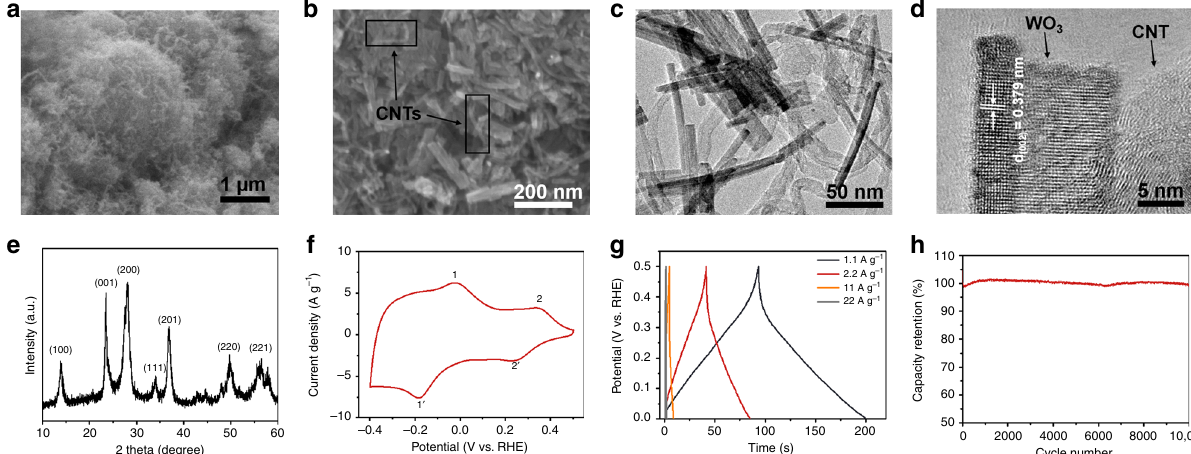
Fig. 2 Structure and electrochemical characterizations of the composite. a , b SEM, c TEM, and d high-resolution TEM images of the composite. e XRD pattern of the composite showing a hexagonal WO 3 crystalline structure. f A cyclic voltammetry curve of the composite from − 0.4 to 0.5 V vs. reversible hydrogen electrode (RHE). g Galvanostatic charge/discharge curves of the composite at different current densities. h Cycling stability of the composite electrode in 0.5 M H 2 SO 4 Fig. 2f, two pairs of well-de fi ned redox peaks (the peaks at 0.23 and 0.34 V, and the peaks at − 0.18 and − 0.02 V, respectively) in Fig. 2f account for adsorption of protons at surface sites and reversible insertion of protons in channels of WO 3 , respectively 27,28 . The symmetric shape of the CV curve indicates an ideal capacitive behavior, in line with our previous study.